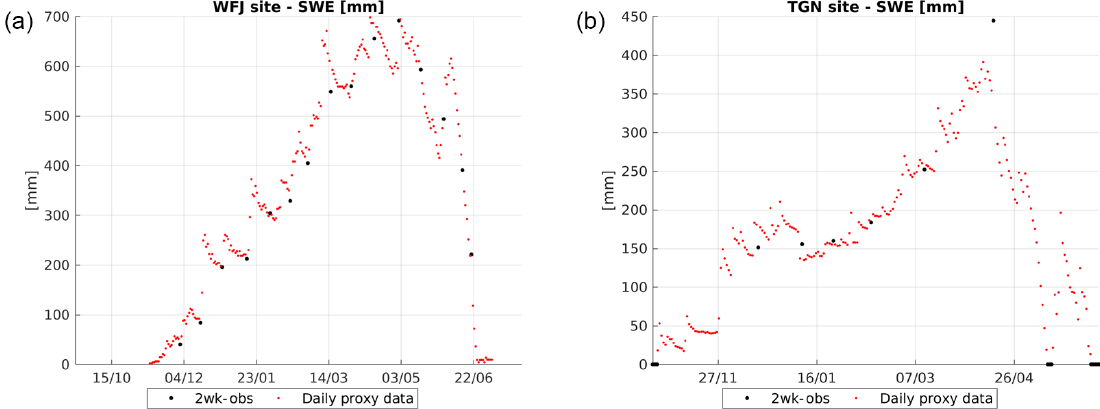
Figure 4. Additional snow density model: comparison between SWE measurements and indirect proxy estimates; WFJ site, winter 2005/2006 (a) and TGN site, winter 2012/2013 (b)